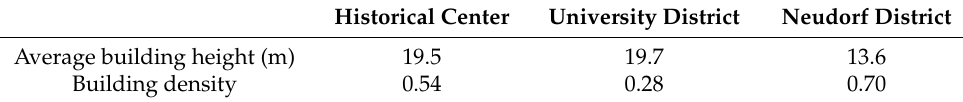
Table 1. Morphological characteristics of each district.